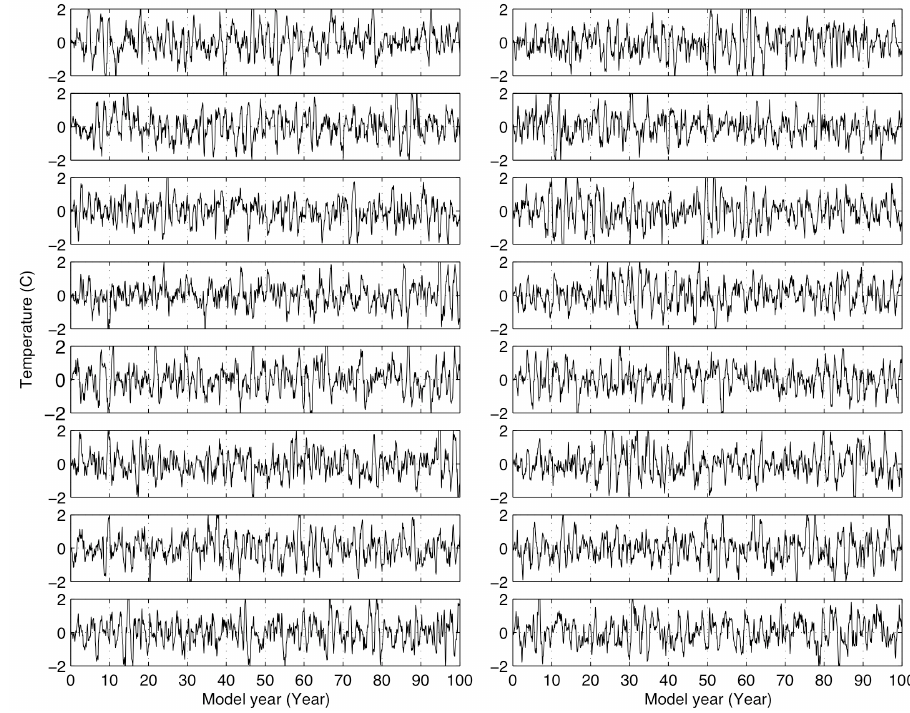
Figure 2. Deviations of the Nino-SST for 16 cases in Experiment 1. 2 Fig. 2. Deviations of the Nino-SST for 16 cases in Experiment